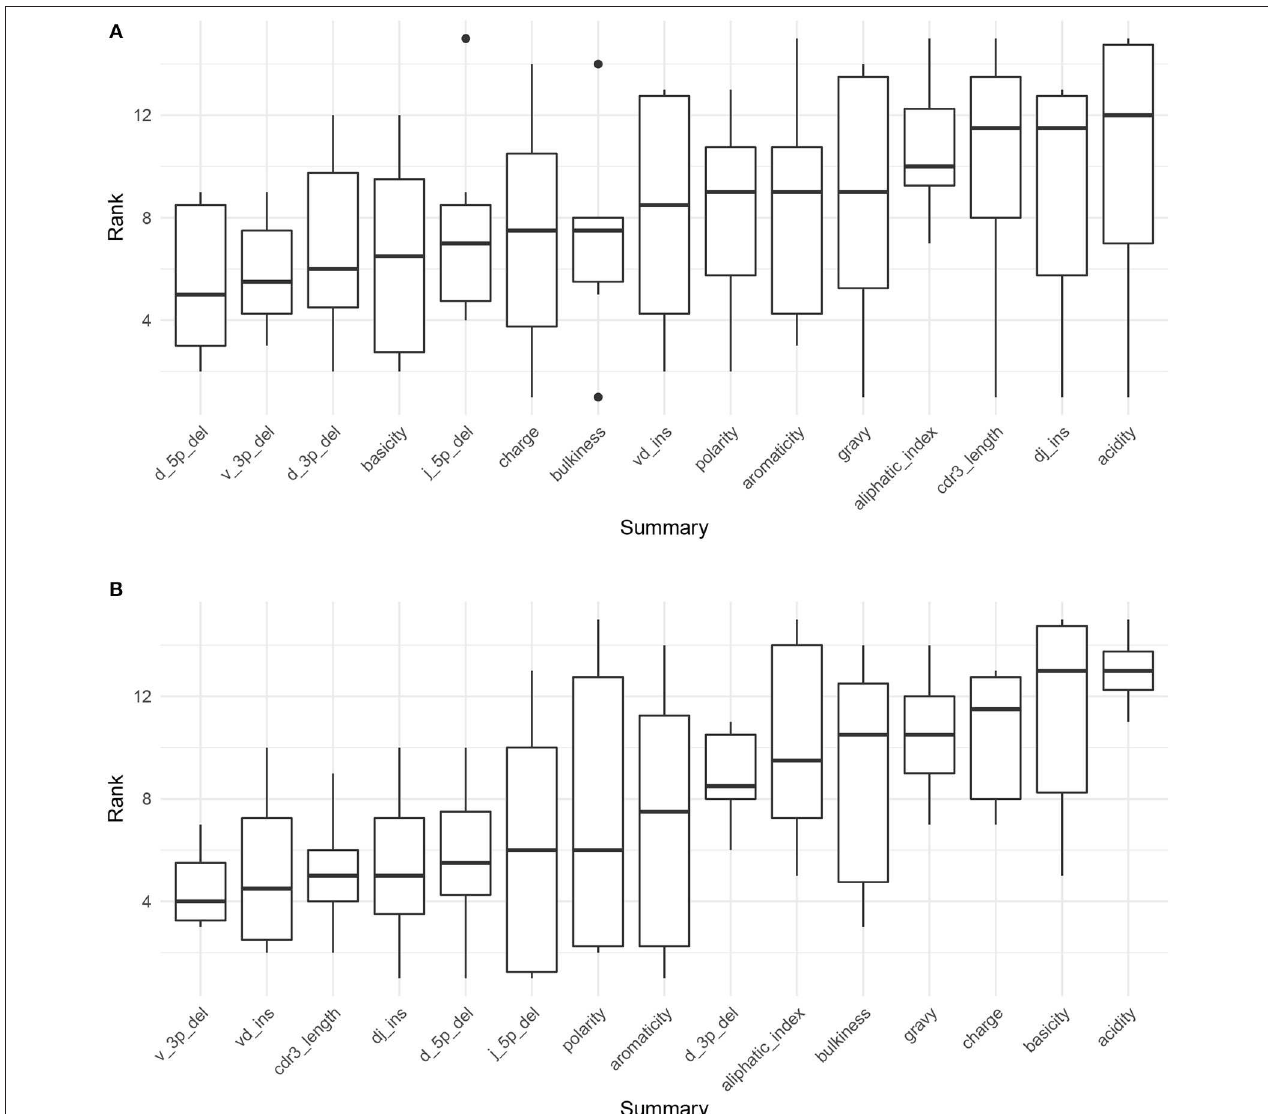
FIGURE 4 | Boxplots of summary rank values taken over each dataset, in order of informativeness, as determined by the median order in which the summary branches off from the lasso paths in Figure S8 , taken over each of the six paths. (A) Summary informativeness rank boxplots using six IGoR -annotated (34) datasets of TRB sequences. (B) Summary informativeness rank boxplots using six partis -annotated (18) datasets of IGH